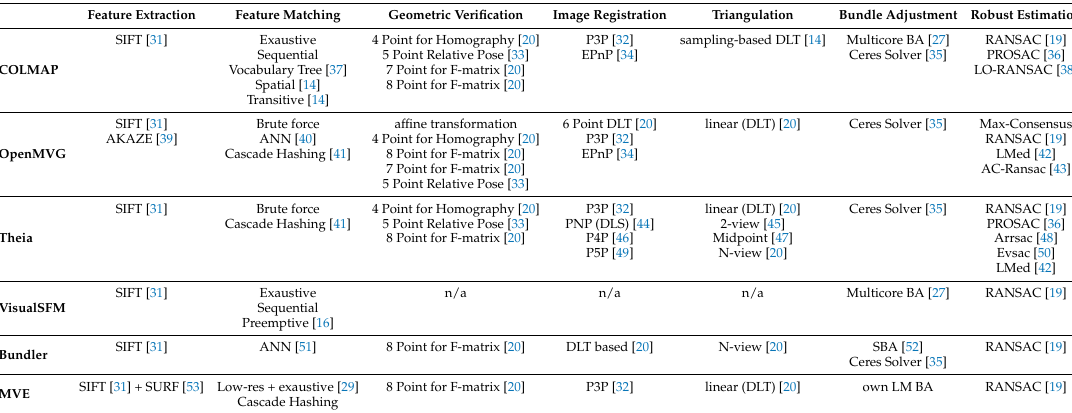
Table 1. Incremental SfM pipelines algorithm